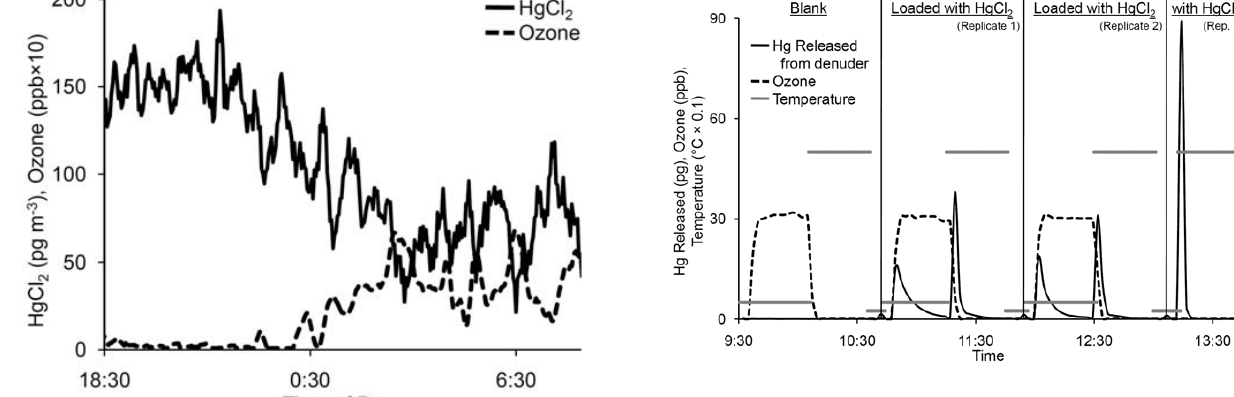
Fig. 4. Mercury released from replicate denuders subjected to Figure 4. Mercury released from replicate denuders subjected to 30 ppb ozone and/or heat, 2 30ppb ozone and/or heat, measured in pg released per 2.5min sam- measured in pg released per 2.5 min sample period of the Tekran 2537B analyzer. The blank 3 concentration (measured 2 ple period of the Tekran 2537B analyzer. The blank denuder was 2 denuder was prepared as described in Section 2.1, and the denuders with HgCl 2 were loaded 4 prepared as described in Sect. 2.1, and the denuders with HgCl 2 was added at a 3 2 were loaded as described in Sect. 2.1. The last denuder in the series as described in Section 2.1. The last denuder in the series was analyzed by heating without 5 was analyzed by heating without ozone. 6